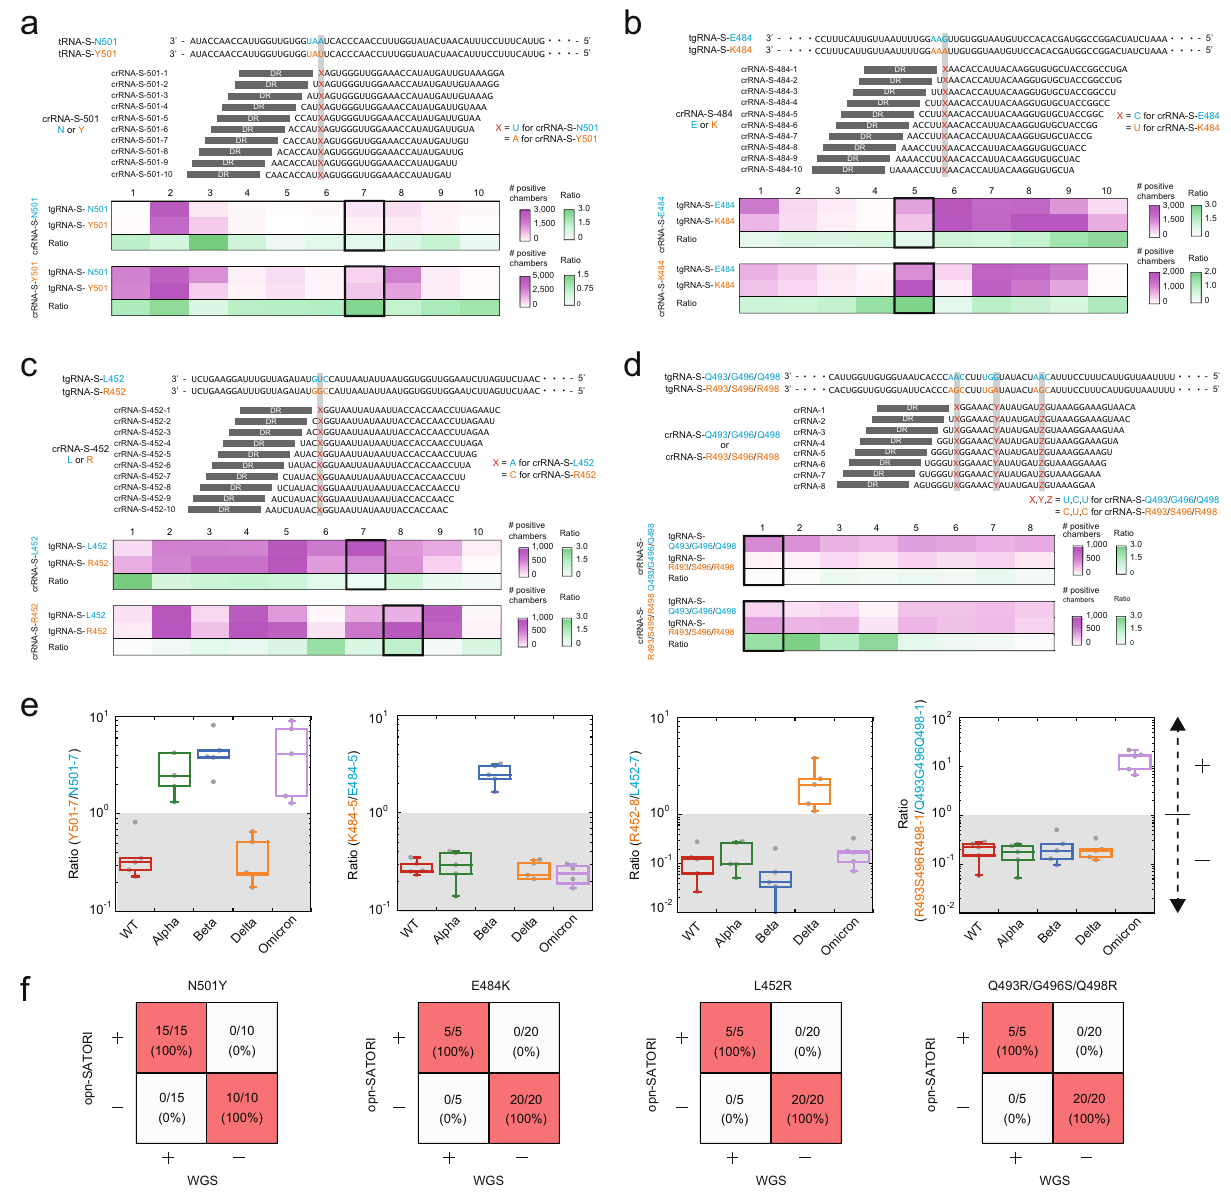
Fig. 3 Discrimination of the S-gene mutations of SARS-CoV-2 variants. a – d Design and screening of crRNA for detection of the N501Y ( a ), E484K ( b ), L452R ( c ), and Q493R/G496S/Q498R ( d ) mutations in the SARS-CoV-2 S-gene ( n = 3 technical replicates). e Discrimination of S-gene mutations in the SARS-CoV-2 variants using opn-SATORI ( n = 5 technical replicates). Wuhan-Hu1, B.1.1.7, B.1.351, B.1.617, and B.1.1.529 were used as WT, α , β , δ , and ο variants, respectively. The de fi nition of having a mutation is that the ratio value is greater than 1.0. In the box plots, the boundary of the box closest to zero indicates the 25th percentile, and black line within the box marks the median, and the boundary of the box farthest from zero indicates the 75th percentile. The error bars indicate S.D. f Detection speci fi city of opn-SATORI. All data were obtained at 3 min after oil